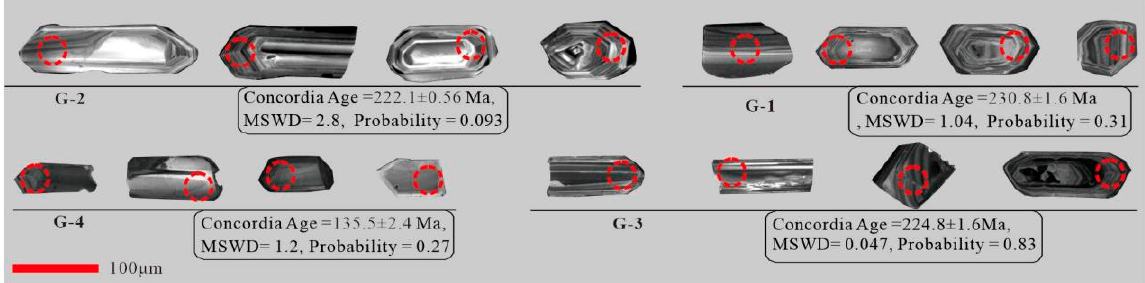
Figure 7. Analysis sites and cathodoluminescence (CL) images of typical zircons.